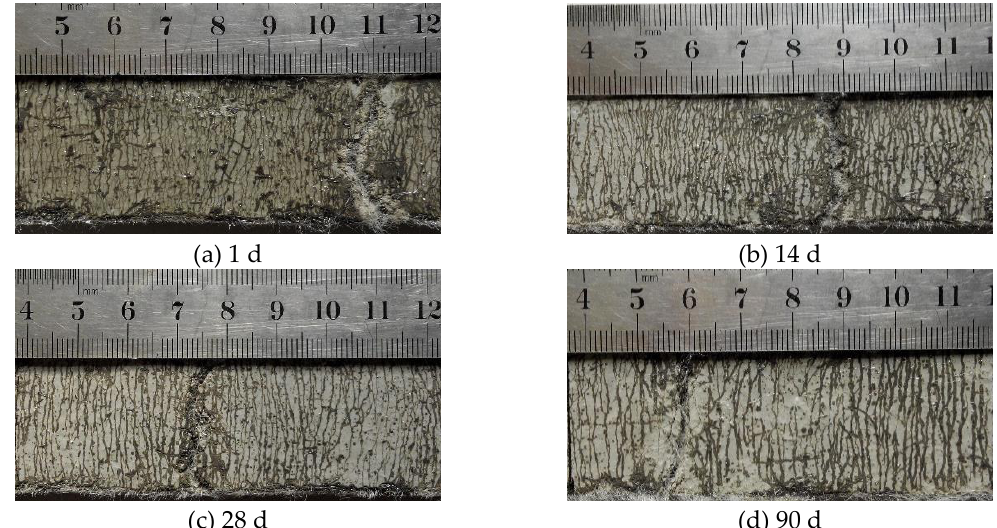
Figure 8. Crack patterns of SHCC specimens under uniaxial tension at different ages.